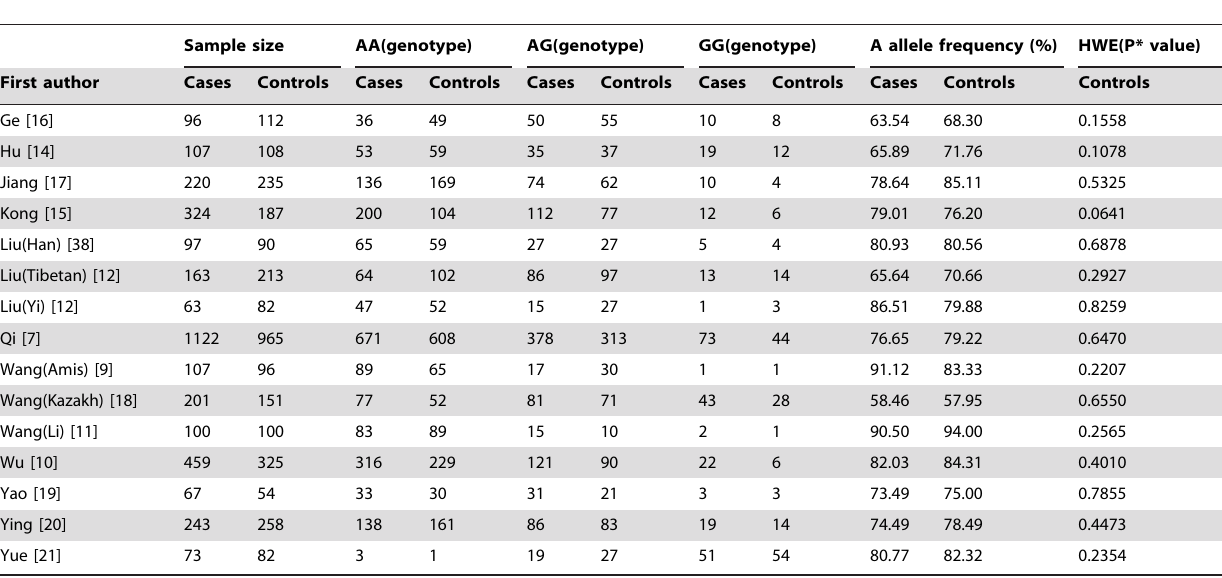
genetic models (A vs. G: P =0.78, OR = 1.05, 95%CI 0.76–1.44, P heterogeneity = 0.24, I 2 = 29%) (Figure 3a). However, in female subjects, the A-6G polymorphism displayed significantly reduced risk for hypertension in the allele comparison (A vs. G: P = 0.01, Table 2. Sample size, the distribution of A-6G genotypes and allele frequencies, and P-values of